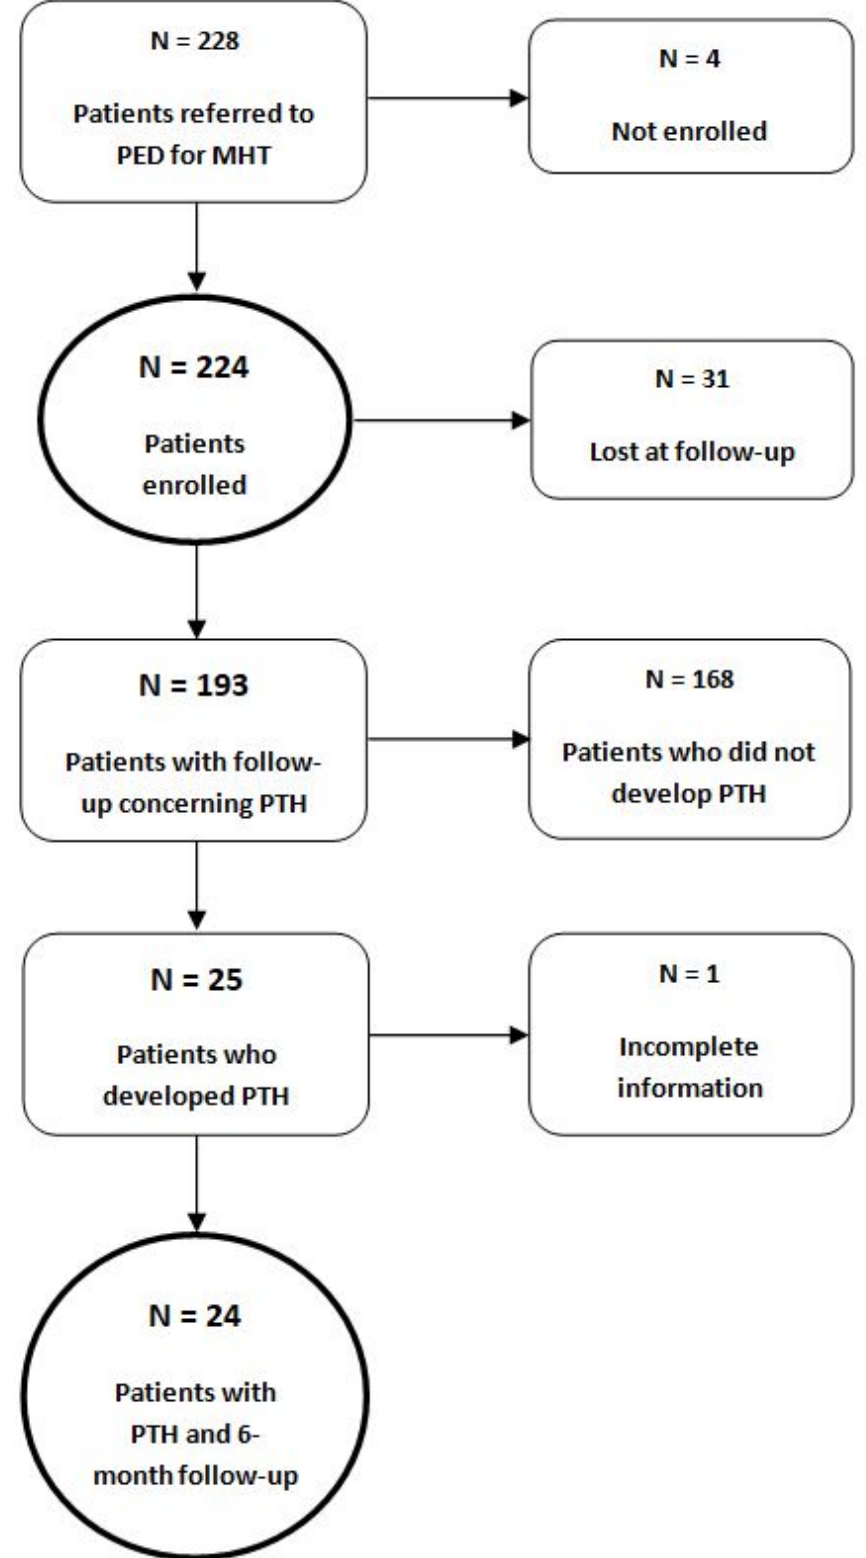
Figure 2. Flow chart of the study population. N = number of patients.